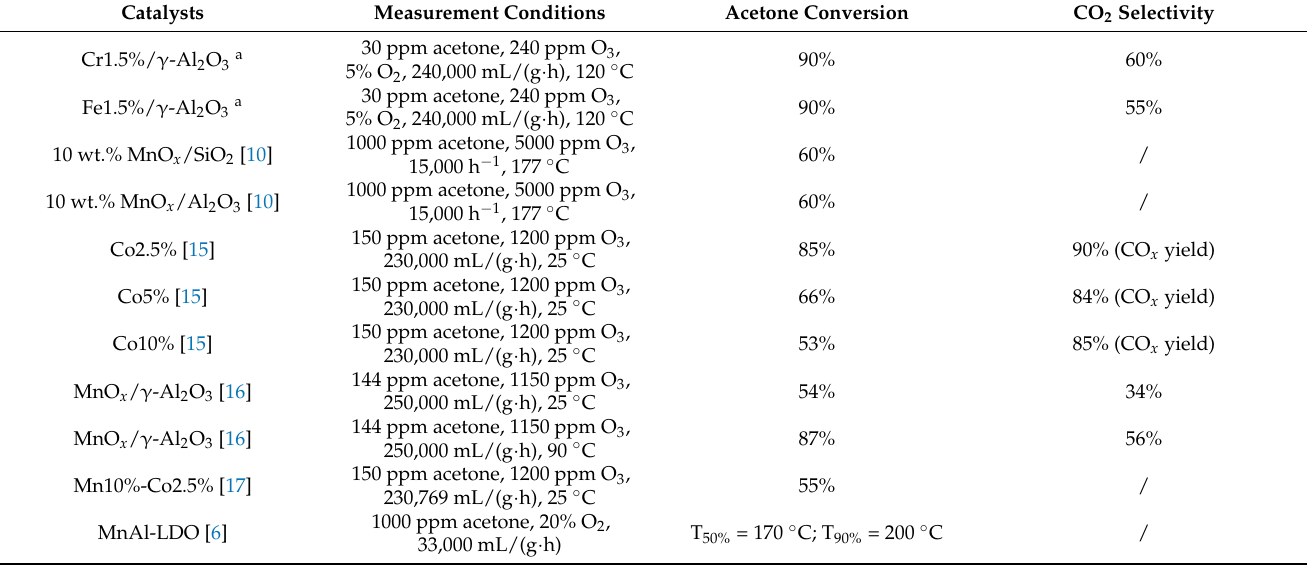
Table 1. Summary and comparison of catalysts for acetone ozonation.